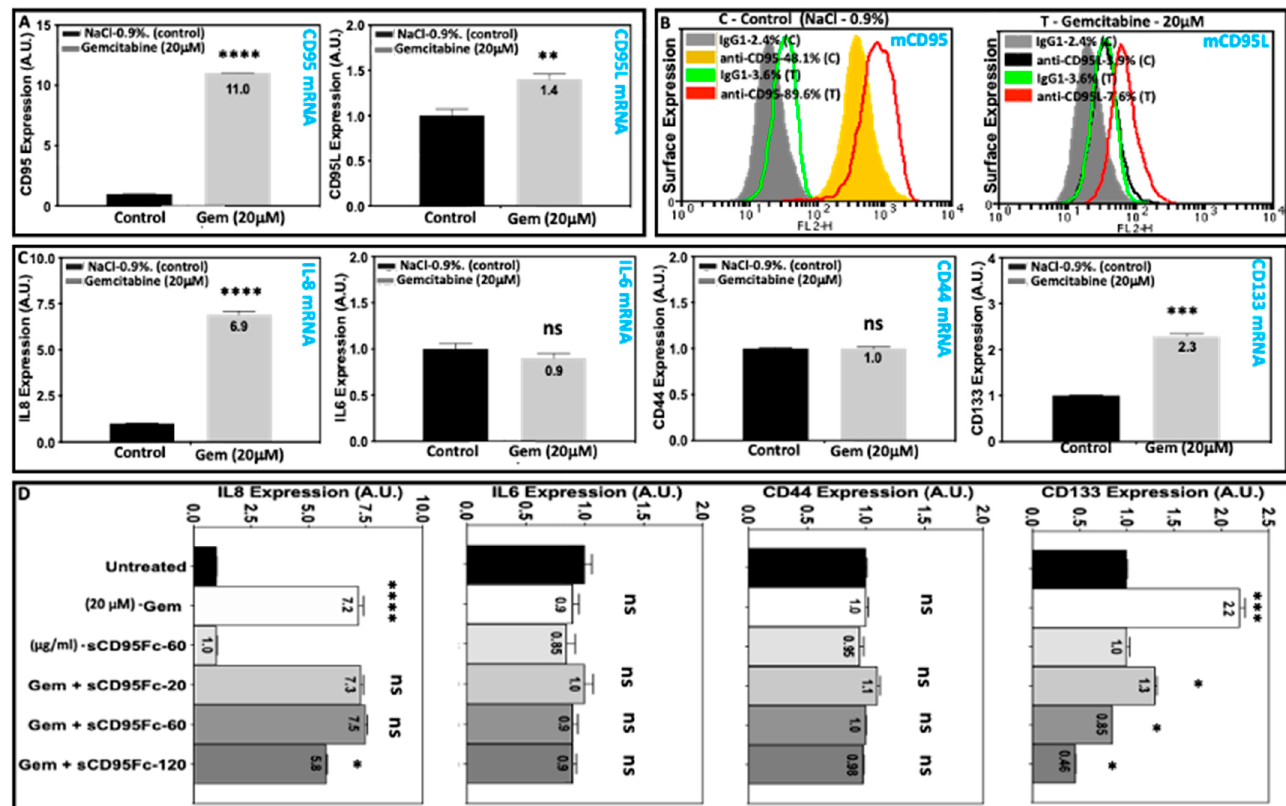
Figure 2. Inhibitory effects of sCD95Fc on the gemcitabine-induced expression of PICs (IL8 and IL6), and PCSC markers (CD44 and CD133) in pancreatic tumor cells. Human PDAC cell line PancTuI-luc was seeded with 2.8 × 10 5 cells/well in a 6-well plate. Cells were either treated with 0.9 % saline ( A – C ) or untreated ( D ) as controls or treated with gemcitabine (20 μ M) alone ( A , C ) or in combination with three different concentrations of sCD95Fc (20, 60, 120 μ g/mL) ( D ). Cells were lysed in RNA Lysis buffer T, total RNA was isolated, and assayed for CD95 and CD95L (A, upper row) or IL8, IL6, CD44 and CD133 ( C , D ) via PerfectProbe real-time RT-PCR assays. Relative expression was normalized to the control and reference gene UBC and expressed as arbitrary unit (AU). Controls were set as 1 in each experiment. Data represent means ± SD of biological replicates ( n = 2) with three technical replicates each. In case of statistical significance, asterisks indicate the corresponding significance levels (Student’s t -test; *, p < 0.05; **, p < 0.01; ***, p < 0.001; ****, p < 0.0001; ns, not significant). ( A , C , D ). B: mCD95 and mCD95L cell surface expression was assayed in non-permeabilized PancTuI-luc using phycoerythrin-conjugated mouse anti-human-CD95 antibody DX-2 (filled yellow peak-untreated and Red line peaks-treated with Gemcitabine (20 µ M) and mouse anti-human-CD95L antibody NOK-1 (black line peaks-untreated and red line peaks -treated with gemcitabine (20 µ M) or an irrelevant antibody (IgGl isotype control) used for the determination of background staining (grey filled peaks-untreated and green line peaks-treated with gemcitabine (20 µ M). Raw data were evaluated as histogram plots as described in Section